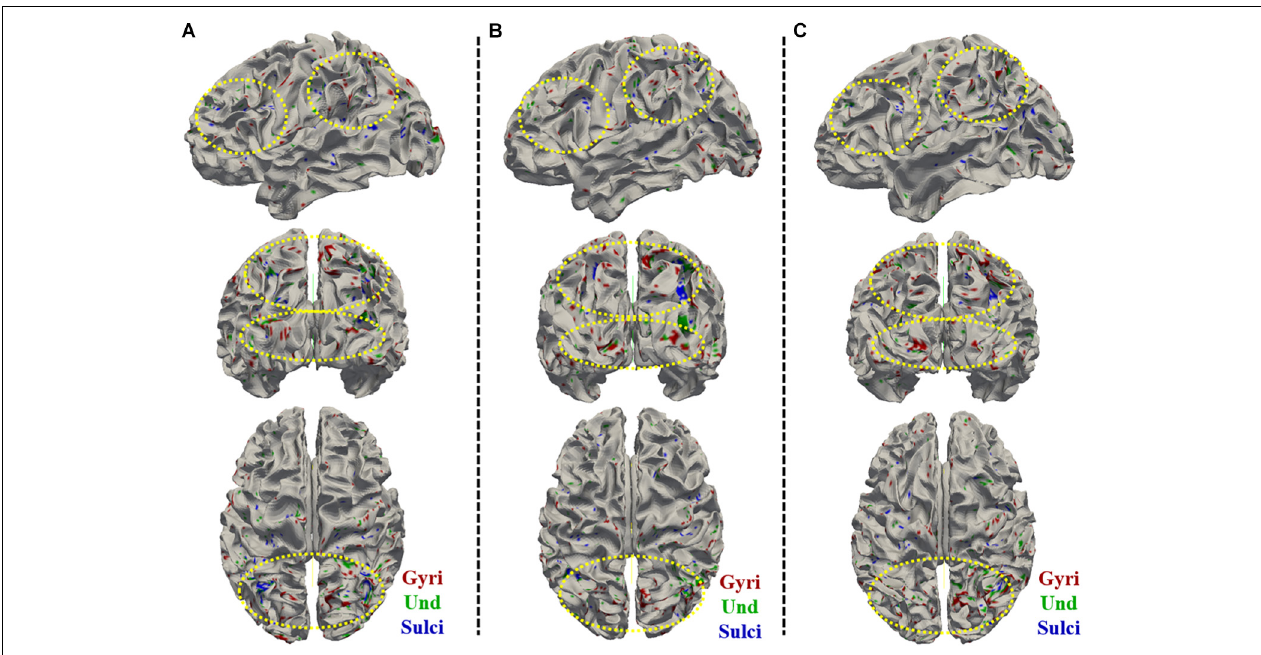
FIGURE 6 | Visualization of the vertices with significant positive correlation between temporal variance and the “number of correct responses” measure across all brain regions on cortical surface across three subjects. (A–C) shows the vertices distribution on cortical surface from three views across three subjects, respectively. The main locations of those vertices on cortical surface are highlighted by yellow dashed